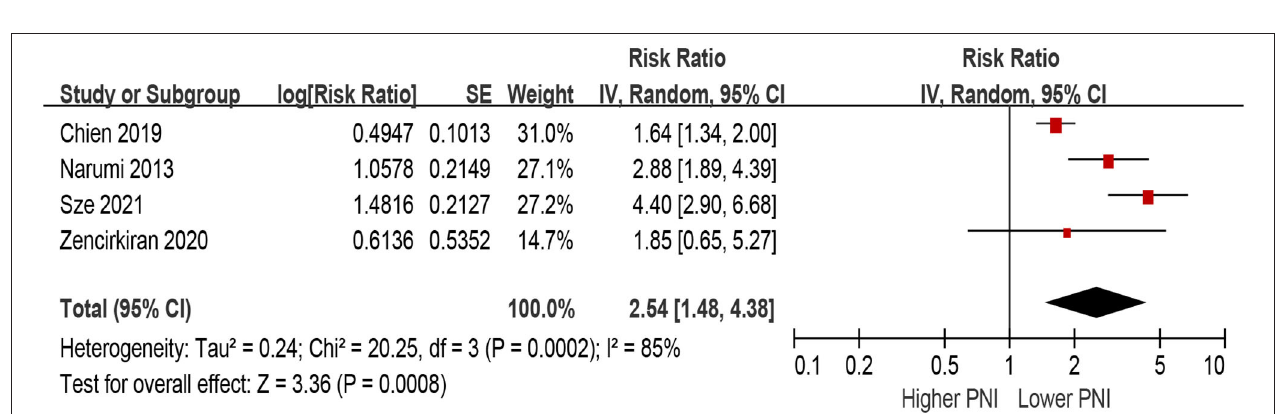
Frontiers in Cardiovascular Medicine | www.frontiersin.org 6 June 2022 | Volume 9 | Article